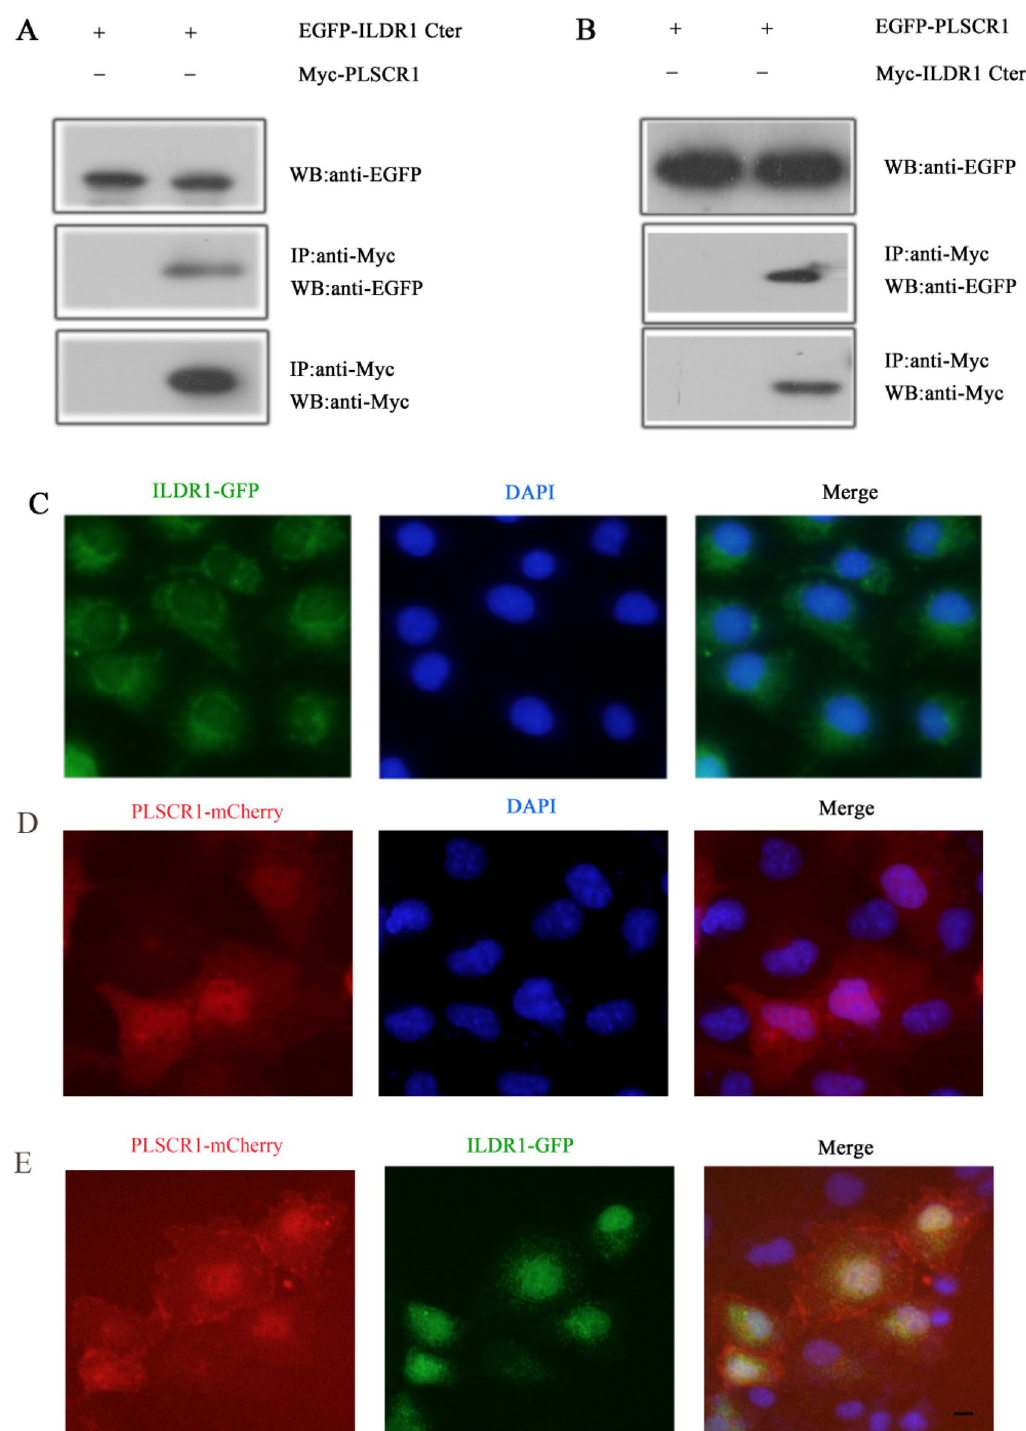
Figure 4. PLSCR1 binds ILDR1. ( A ) Western blots showing that EGFP-tagged cytoplasmic fragment of ILDR1 was co-immunoprecipitated with Myc-tagged PLSCR1. ( B ) Western blots showing that EGFP- taggedPLSCR1 was co-immunoprecipitated with Myc-tagged cytoplasmic fragment of ILDR1. Expression vectors were transfected into HEK293T cells to express epitope-tagged proteins, and cell lysis were subject to immunoprecipitation.5% of total protein was loaded as input. IP indicates antibody used for immunoprecipitation and WB indicates antibody used for detection. ( C ) ILDR1-EGFP localize in the cytoplasm of COS7. ( D ) PLSCR1-mCherry localize both in the nucleus and cytoplasm of COS7. ( E ) However, when PLSCR1-mCherry is present, ILDR1-GFP translocates into the nuclei. Expression vectors were transfected into COS-7 cells to express epitope-tagged proteins. Nuclei were stained with DAPI. Scale bar: 10